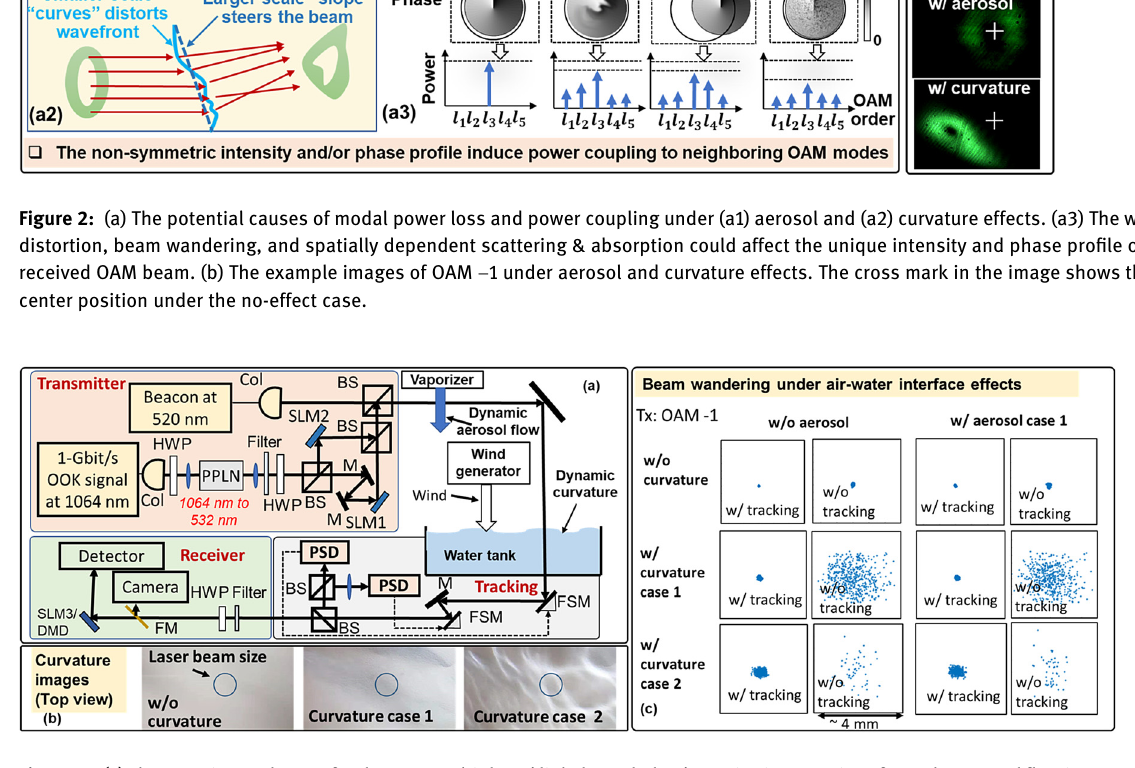
Figure3: (a)TheexperimentalsetupfortheOAMmultiplexedlinkthroughthedynamicair – waterinterface.The aerosolflowisgeneratedbya vaporizer, and the curvature of the interface is induced by wind. Col, collimator; PPLN, periodically poled lithium niobate; BS, beam